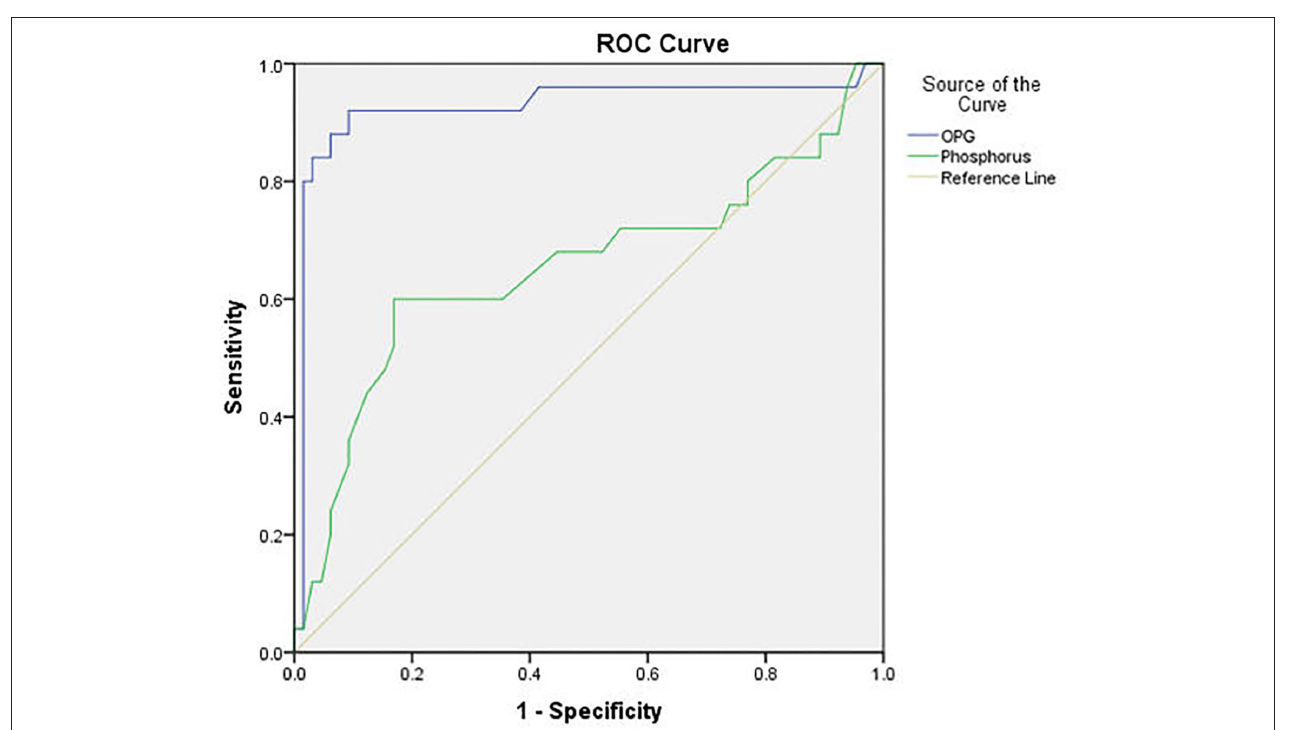
FIGURE 5 | ROC curve of serum osteoprotegerin and phosphorus level in predicting cardiovascular calcification.